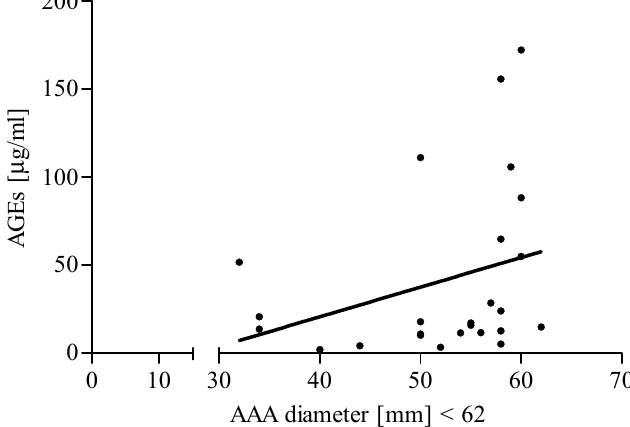
Figure 5. Correlation between AGEs level and aneurysm diameter in abdominal aortic aneurysms (AAA) patients (diameter < 62 mm). Spearman correlation coe ffi cient r = 0.4315, p = 0.0313.